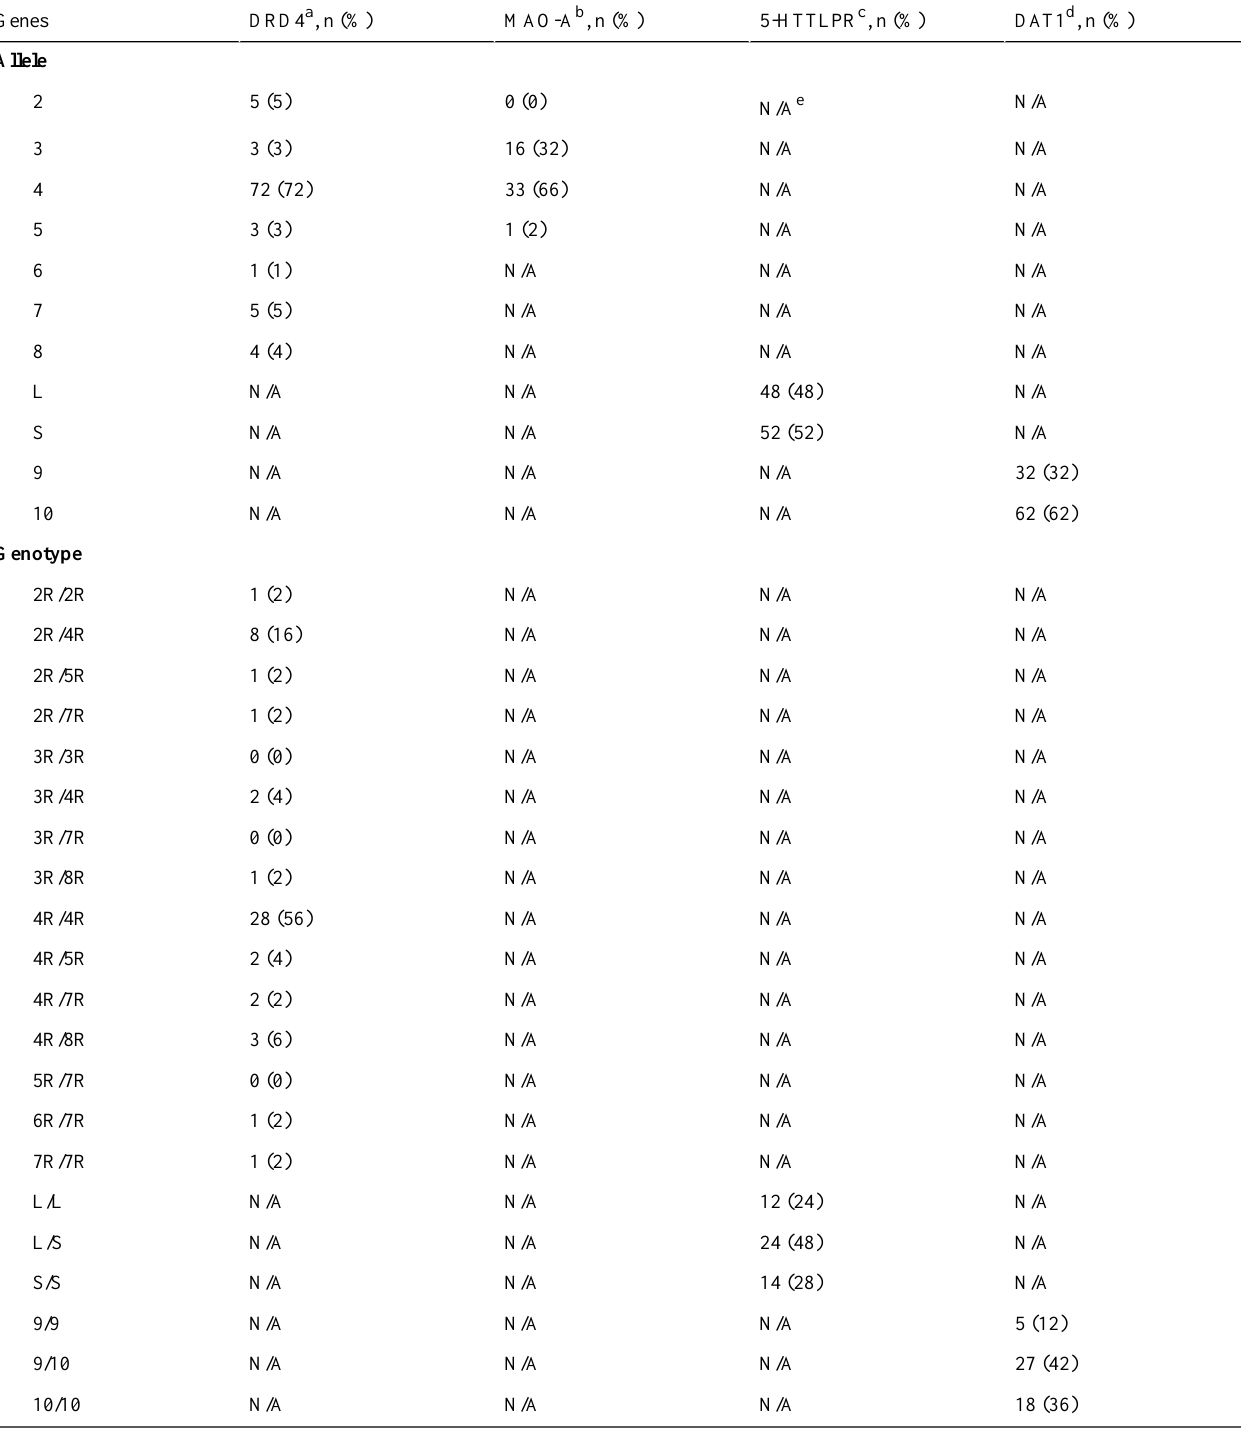
Table 1. Allele and genotype frequencies of the dopamine D4 receptor, monoamine oxidase A, serotonin-transporter, and dopamine active transporter 1 genes among